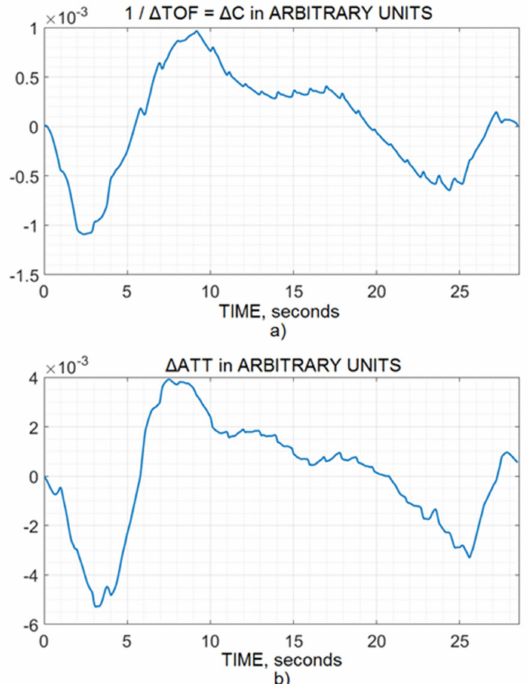
Figure 3. Vasodilatation dynamics of intracranial blood vessels caused by the breath-holding test and